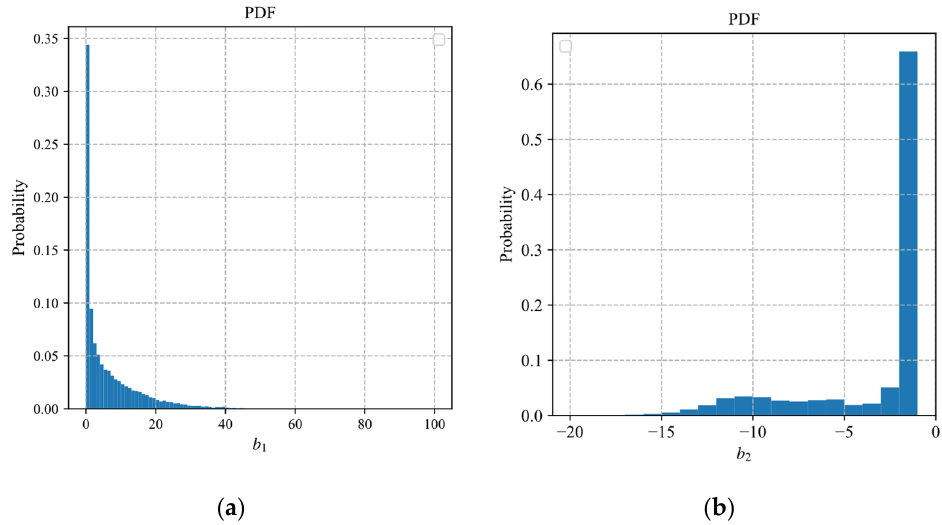
b and Figure 8. The probabilistic histograms of parameters b 1 and b 2 : ( a ) b 1 ; ( b ) b 2 . 1